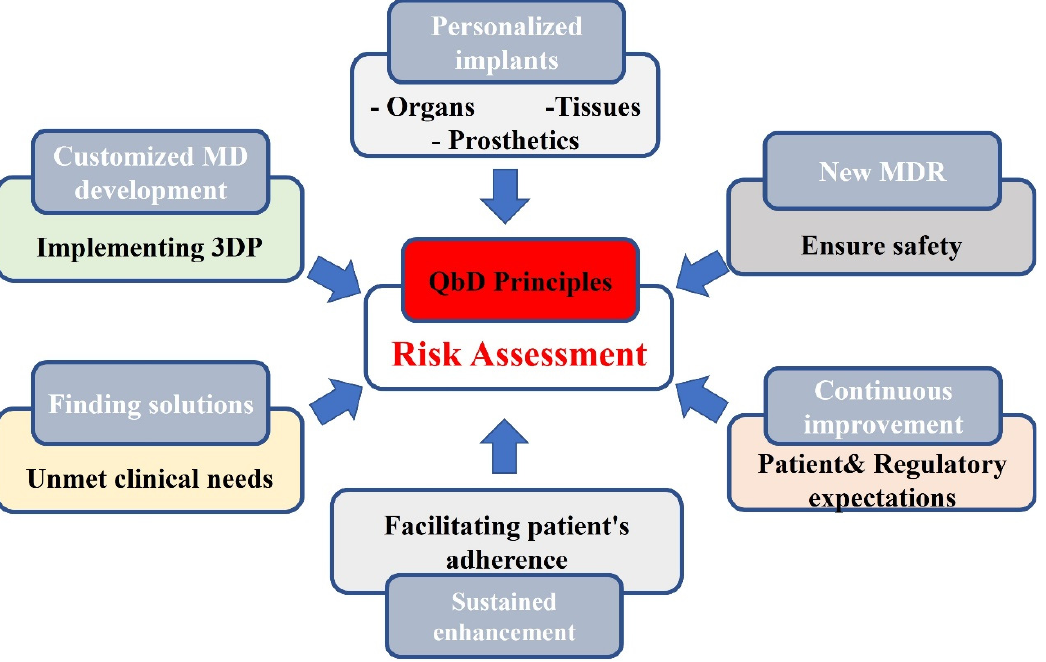
Figure 3. Fostering 3D printed MD development via a QbD quality management framework. Ab- breviations: QbD quality by design, 3DP 3D printing, MD: Medical devices MDR Medical Device Regulation.